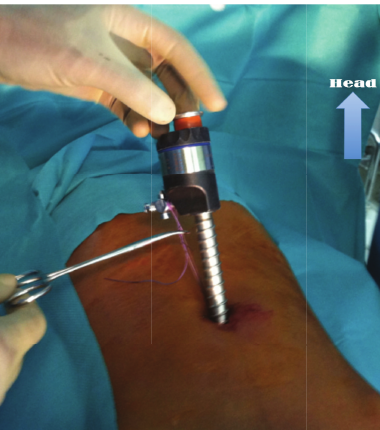
Figure 1: Open coelioscopy (umbilical trocar fixation during lap- aroscopic appendectomy).